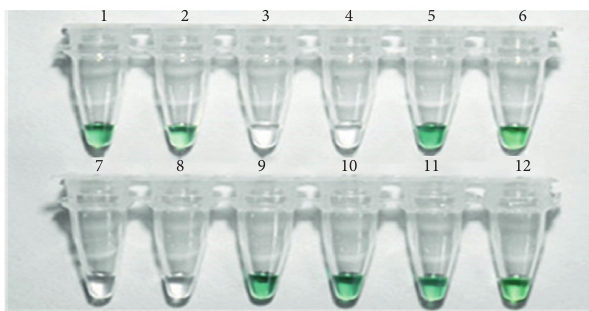
Figure 3: Colorimetric detection results for soybean GmSg-1 a /GmSg-1 b genes. Photograph of HCR assay solutions containing hemin (1.2 μ M), Triton X-100 (0.002%), ABTS (3.8 μ M), H 2 O 2 (1.5mM), and target